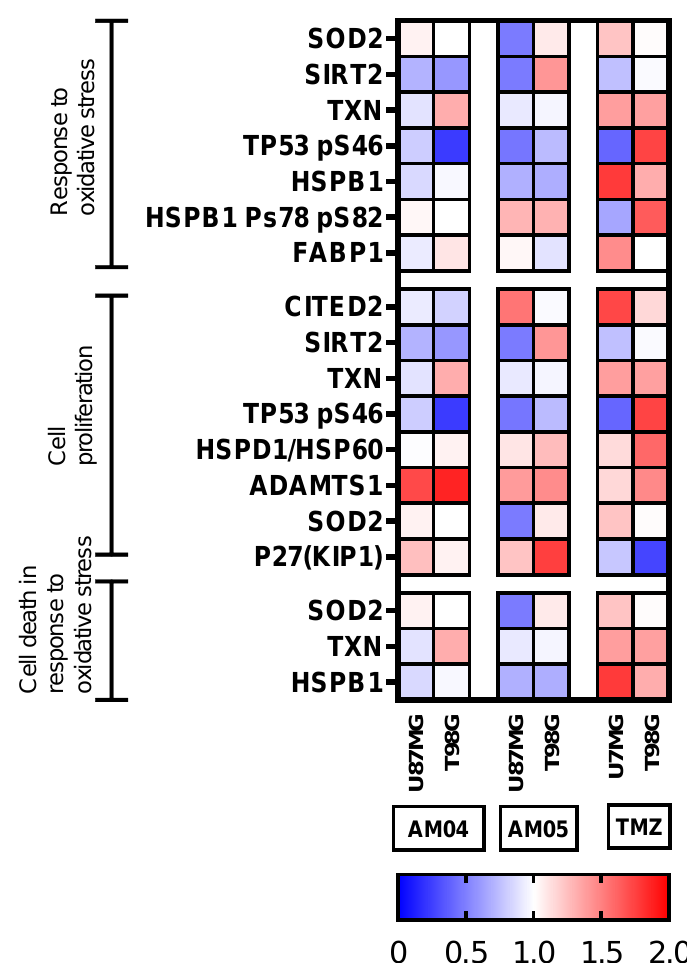
Figure 6. Proteome profiler of protein-related to cellular stress based on antibody array. Performed for duplicates of antibody spots for each condition.